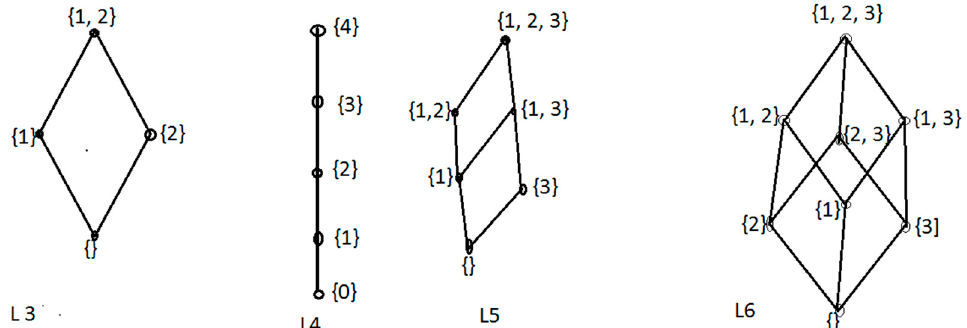
Figure 2. Complete bounded distributive lattices .